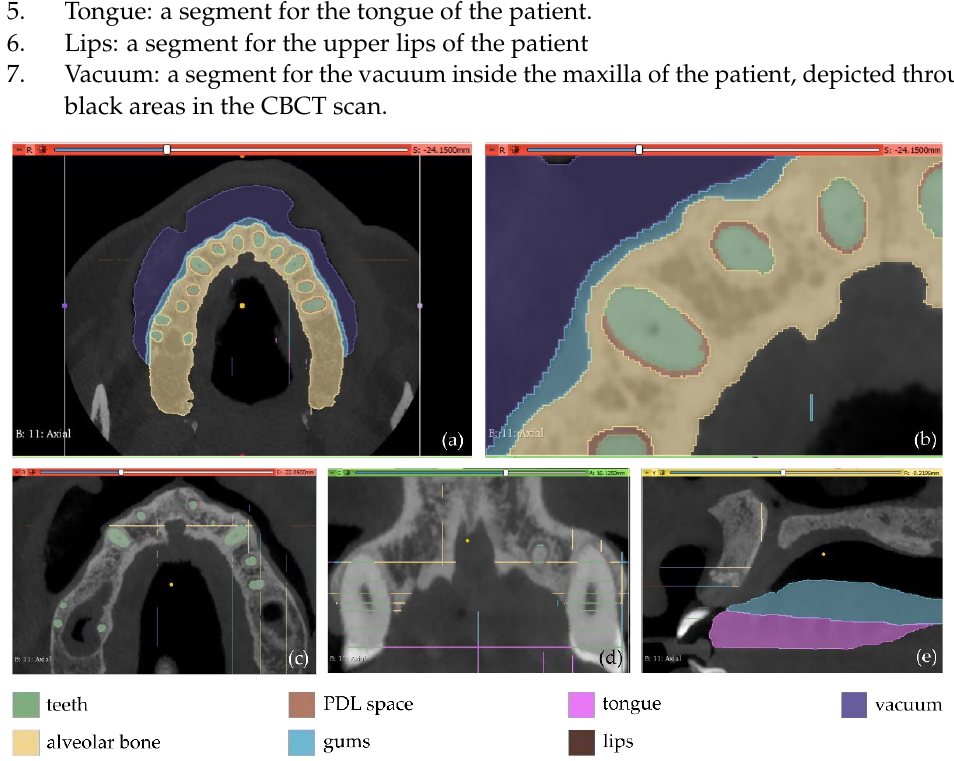
Figure 1. Manual definition of segments in 3D Slicer using CBCT slices of the maxilla of a patient within Experiment 1; ( a ): a CBCT slice in the axial plane; ( b ) zoom-in view of the CBCT slice in the axial plane, shown in ( a ); ( c ) zoom-in view of another CBCT slice in the axial plane; ( d ) zoom-in view of a CBCT slice in the coronal plane; ( e ) zoom-in view of a CBCT slice in the sagittal plane. The aforementioned segments were defined in a few slices (<15 slices) by manual painting either parts of them or the entire segments where they were visible. The “Grow from seeds” method available in 3D Slicer was applied using the painted parts of segments in the defined slices. This method starts from these “seeds”, i.e., the painted segments inside each anatomical structure, and grows them to achieve a complete segmentation, using a variation of the GrowCut algorithm [36] designed for medical images, as described in [37]. The results of the “Grow from seeds” method in a few CBCT slices along with the 3D reconstructed volumes derived by the segmentation are shown in Figure